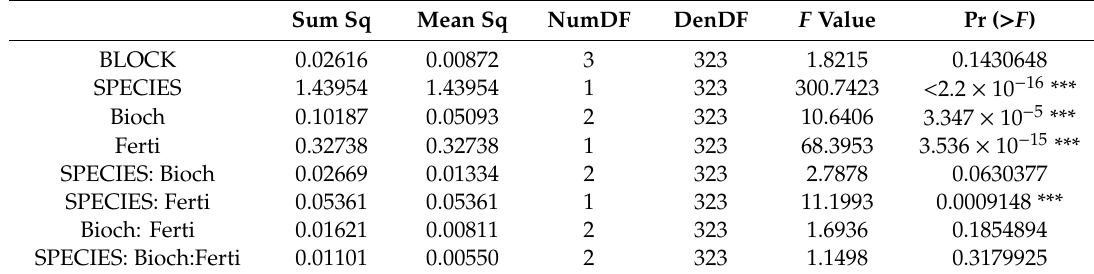
Table A7. Monthly Growth in Diameter.